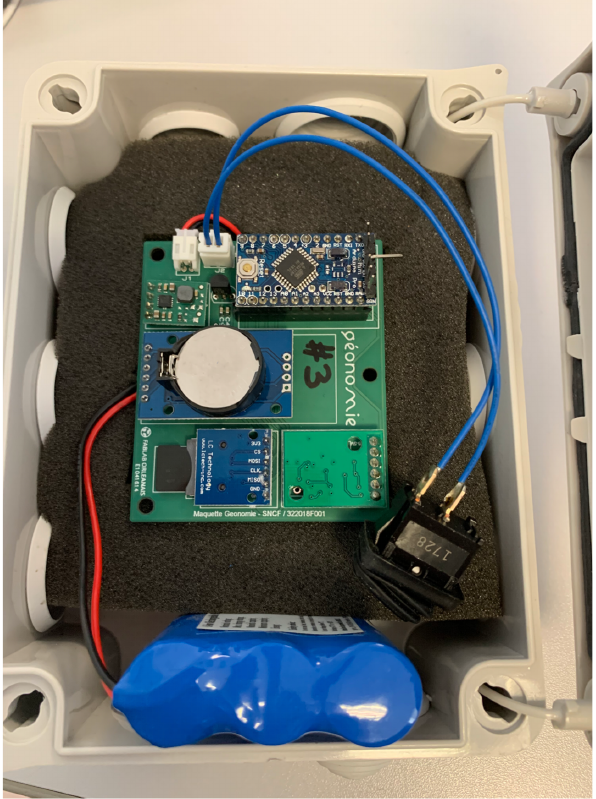
Figure 8. Nine-DoF LSM9DS1 embedded with Arduino Pro